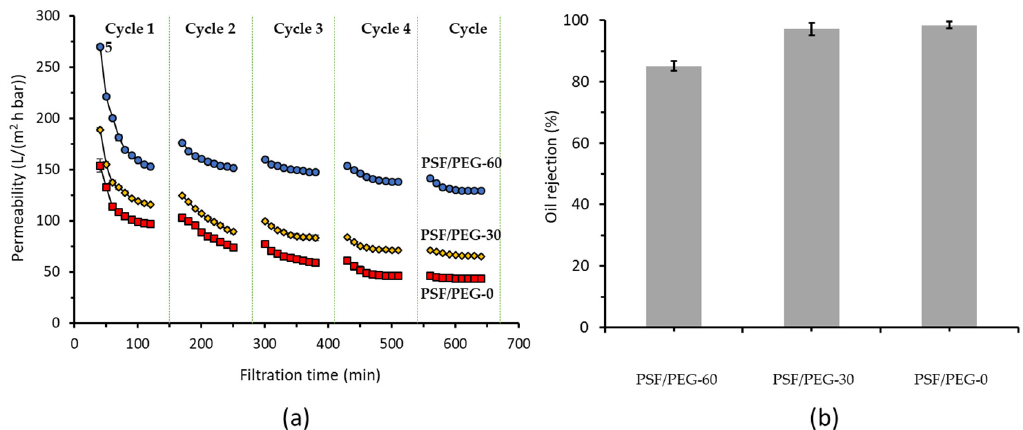
Figure 3. Effect of membrane material on the filtration performance ( a ) and oil rejection ( b ). The tests were conducted at a constant transmembrane pressure of 0.2 bar for treating 1000 ppm oil/water emulsion feed. The first 30 min of filtration in the first cycle was done for clean water permeability measurement.